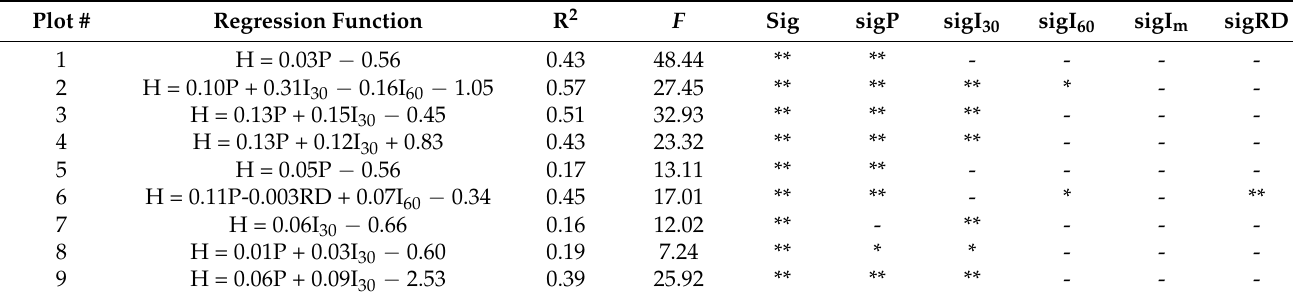
Table 5. Multiple regression analysis for runoff depth (H) and the five rainfall eigenvalues of rainfall amount (P), rain- fall duration (RD), mean rainfall intensity (I m ), maximum 30 min rainfall intensity (I 30 ), and maximum 60min rainfall intensity (I 60 ).